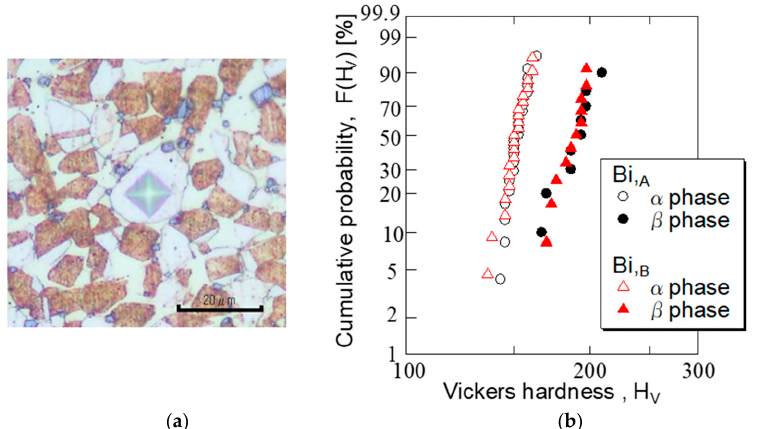
Figure 3. Statistical distribution of HV in the α and β phases. ( a ) Indentation morphology ( α -phase of Bi, B ); ( b ) statistical distribution of HV (Bi, A and Bi, B materials).